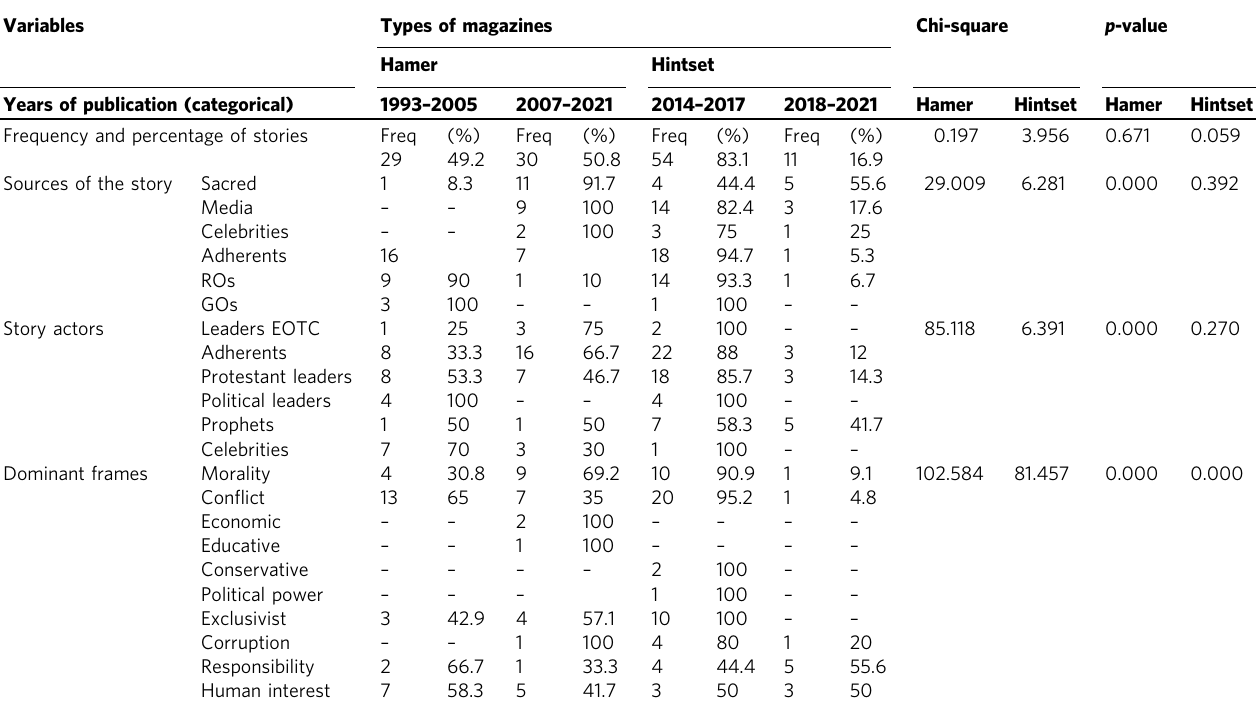
Table 7 Cross-tabulation: Peace development * Types of publication * Years of publication * Sources * Story actors * Dominant